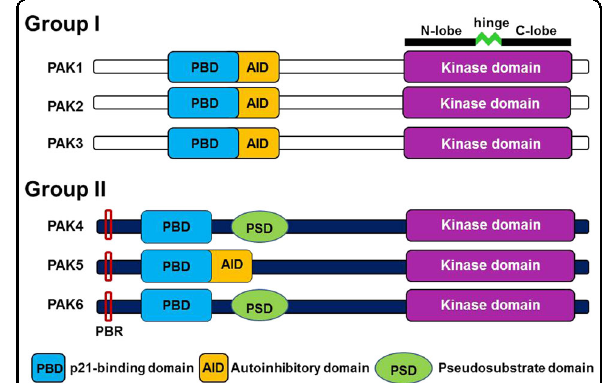
Fig. 1 Domain architecture of PAK family kinases. Group I PAKs contain an overlapping PBD and AID in their N-terminal regions. Among the group II PAKs, PAK5 also contains a PBD and an AID. In contrast, PAK4 and PAK6 lack the AID but contain the PBD and PSD. Group II PAKs all contain a polybasic region (PBR), but its role has only been de fi ned for PAK4 (see the main text for detail). N-lobe N-terminal